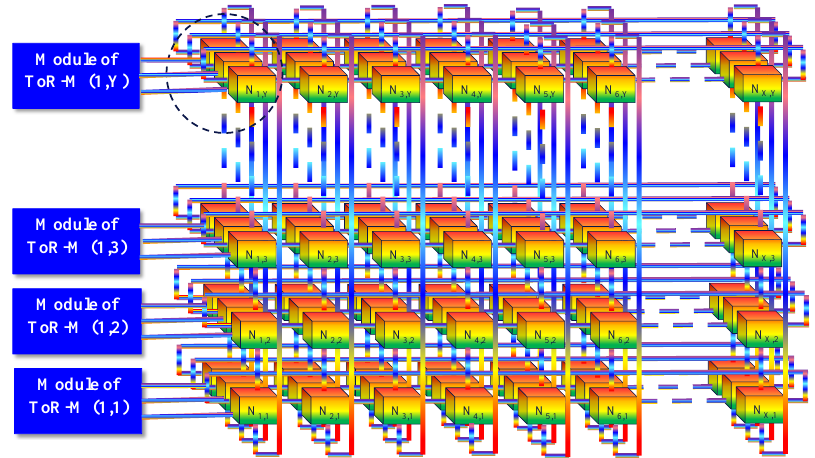
Figure 7. Three-plane Torus topology optical tunnel switching network with 49 nodes.